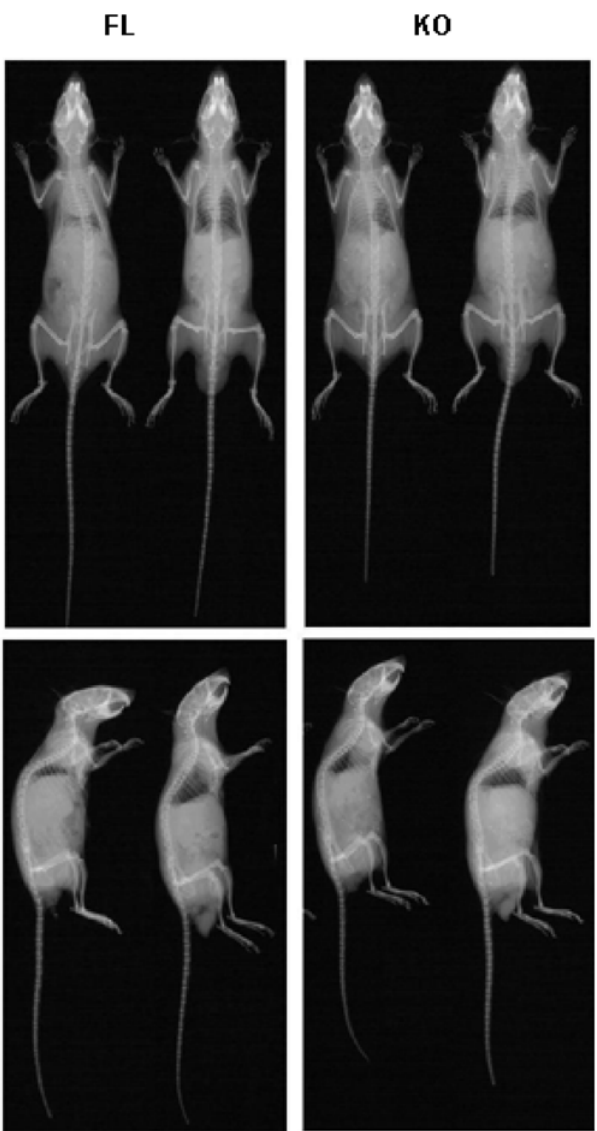
Figure 7. Role of OGR1 in osteoclastogenesis of the mixed and the C57/BL6 background mice. Radiographs of WT (left) and KO (right) mice (conducted in Mouse Phenotyping Shared Resource, Ohio State